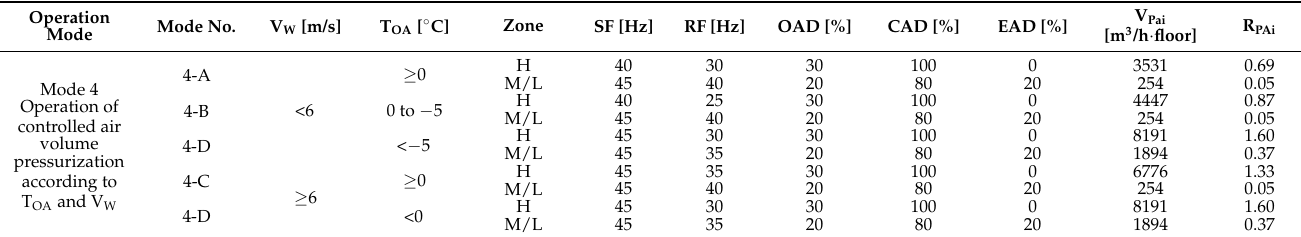
Table 3. HVAC system operating conditions in winter 2015. The HVAC pressurization method was classified into four operation modes according to the outdoor temperature and the wind